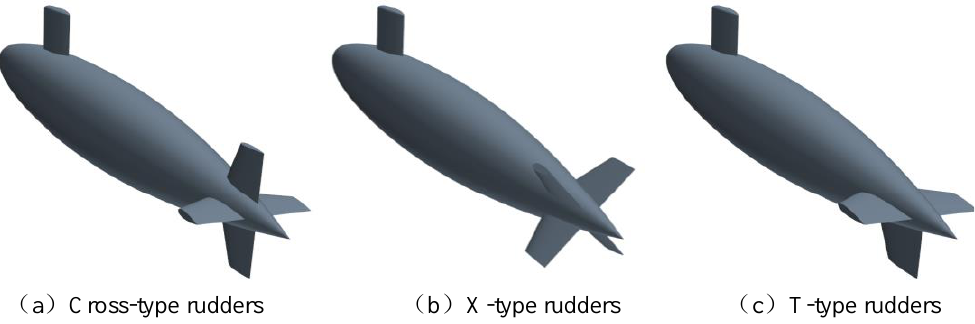
Figure 14. Geometry of underwater vehicle with full appendages.